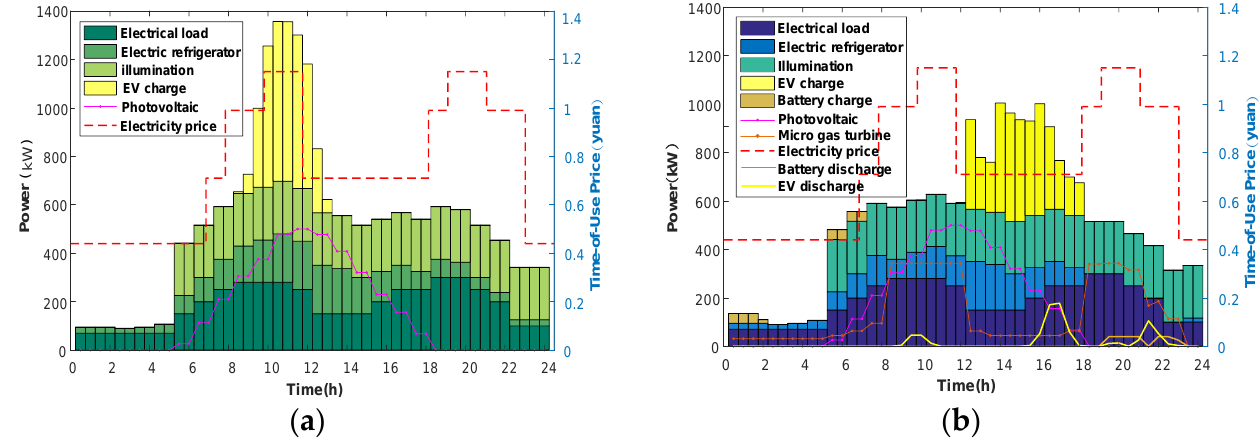
Figure 5. Electric power optimization results: ( a ) before optimization; ( b ) after optimization.